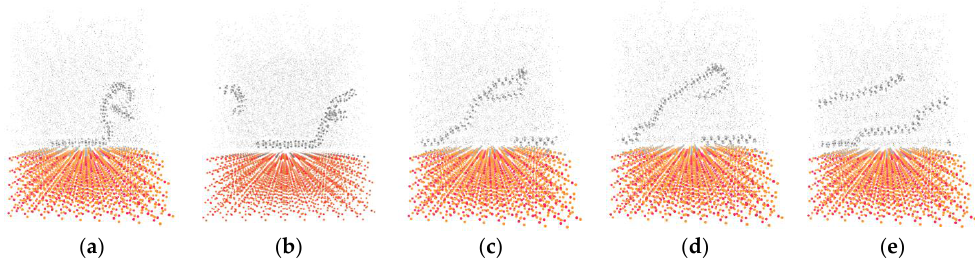
Figure 8. Snapshots of shear simulation of PE(76 – 40)/S interface at various displacements: ( a ) 2 Å , ( b ) 14 Å , ( c ) 50 Å , ( d ) 100 Å , and ( e ) 200 Å .